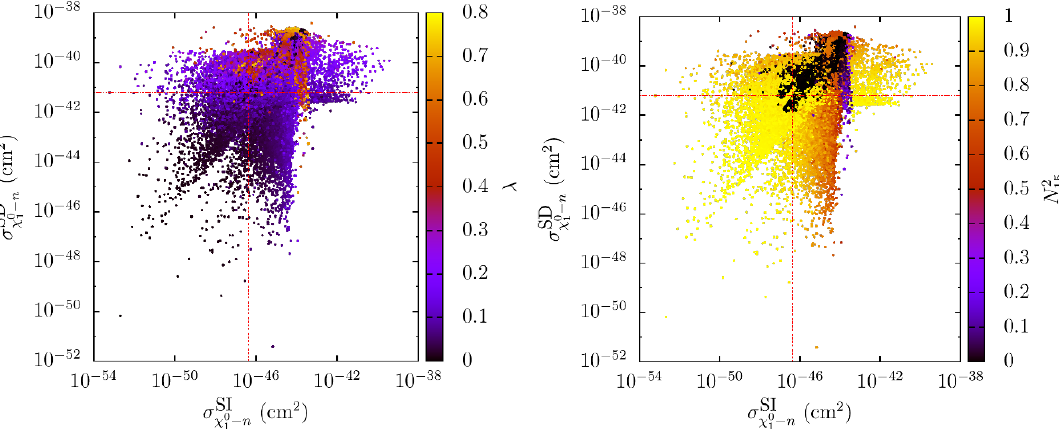
Figure 3 . Scatter plots in the plane of σ SI indicating the values of λ (singlino fraction σ SD χ 0 1 χ 0 1 n − n − − )) from the palette in the left (right) plot while satisfying 0 . 107 < Ω h 2 < 0 . 131. in the LSP (= N 2 15 Observed upper bounds of the DMDD-SI and DMDD-SD cross sections are indicated by the red- dashed lines vertical and parallel, respectively, to the abscissa thus indicating that points in the bottom left quadrant simultaneously satisfy bounds on